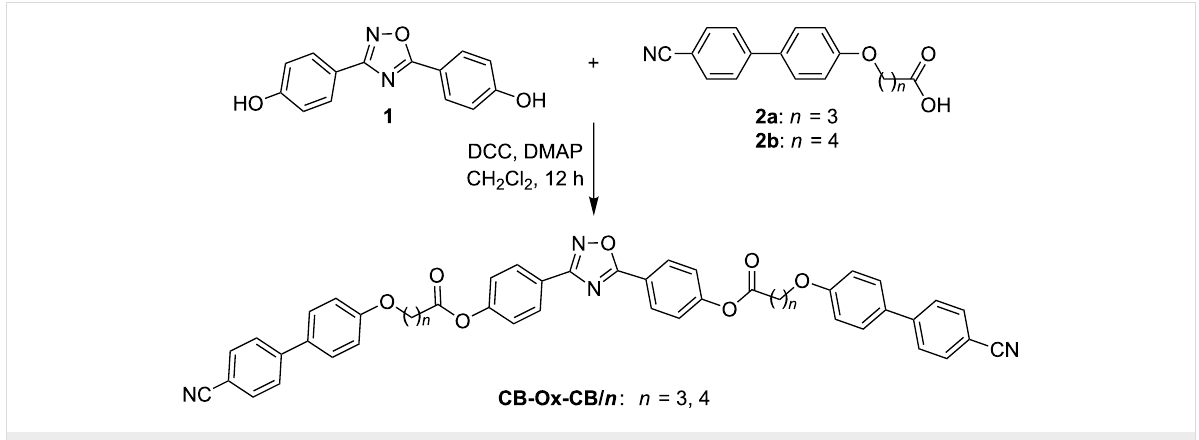
Scheme 2: Synthesis of the ABA-heterotrimesogens CB-Ox-CB/ n .